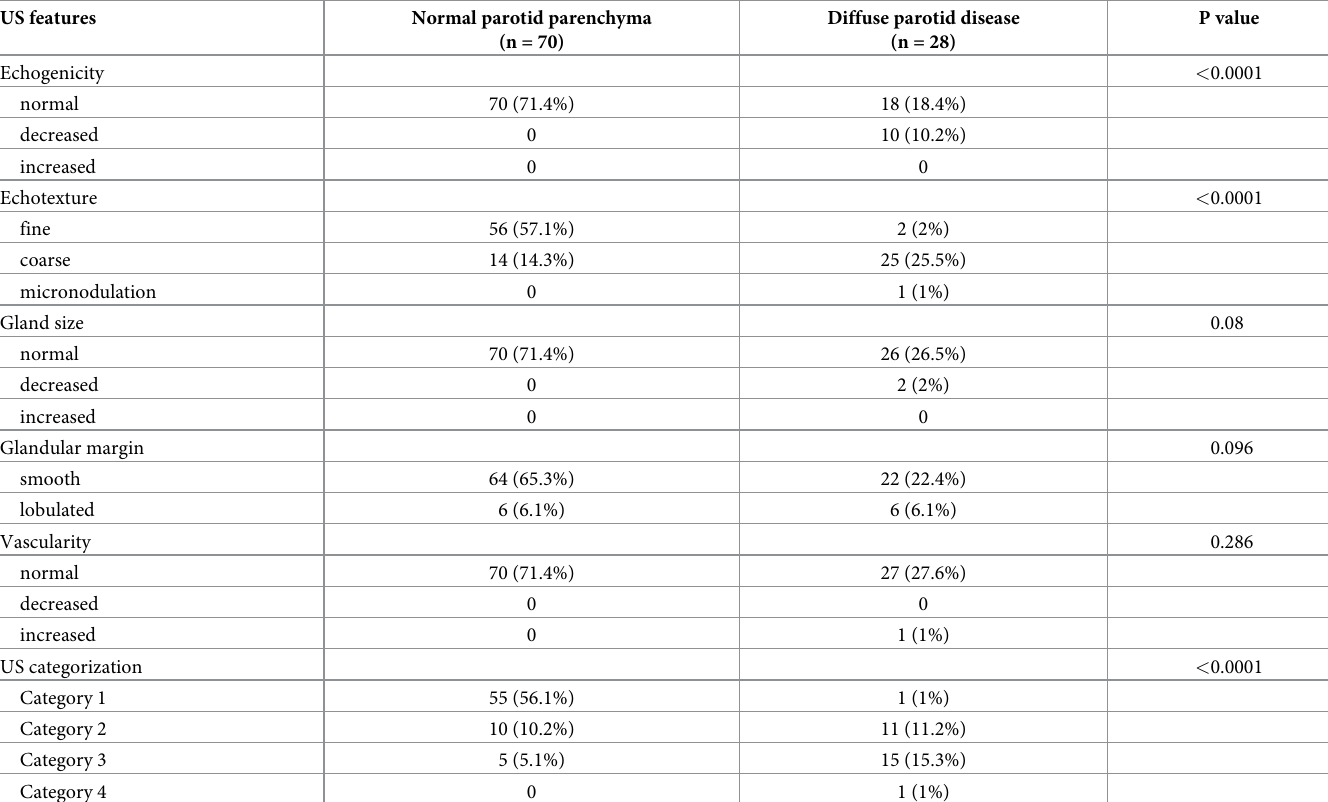
Table 1. Frequency analysis of ultrasound features of the normal parotid parenchyma and diffuse parotid disease in 98